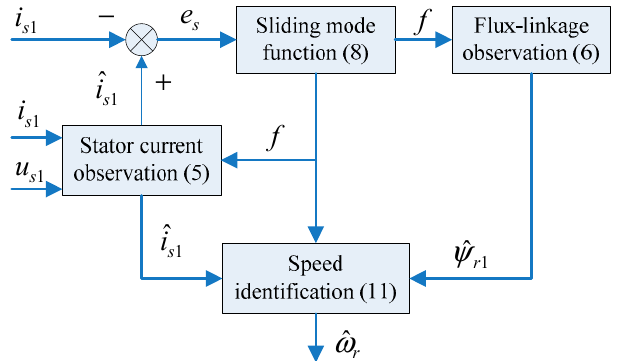
Figure 2. Schematic diagram of speed sliding mode observer.